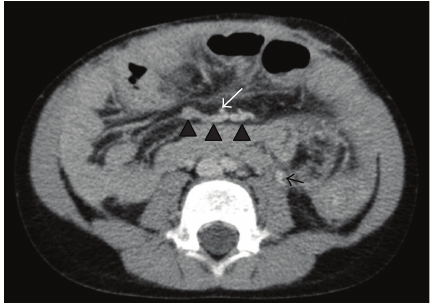
Figure 6: Post IV contrast transverse axial CT scan: SMA (white arrow), no normal SMV demonstrated, confluence of collateral veins (black arrow heads), large inferior mesenteric vein that drains to the splenic vein (black solid